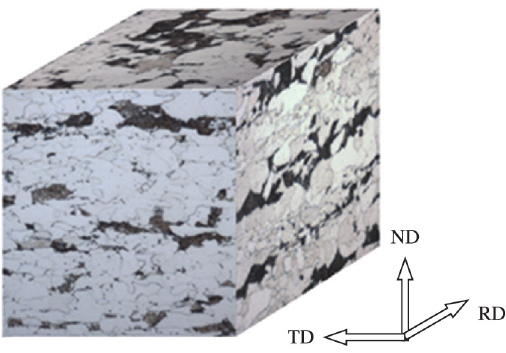
Figure 4. Microstructure from the API X70 steel in 3D